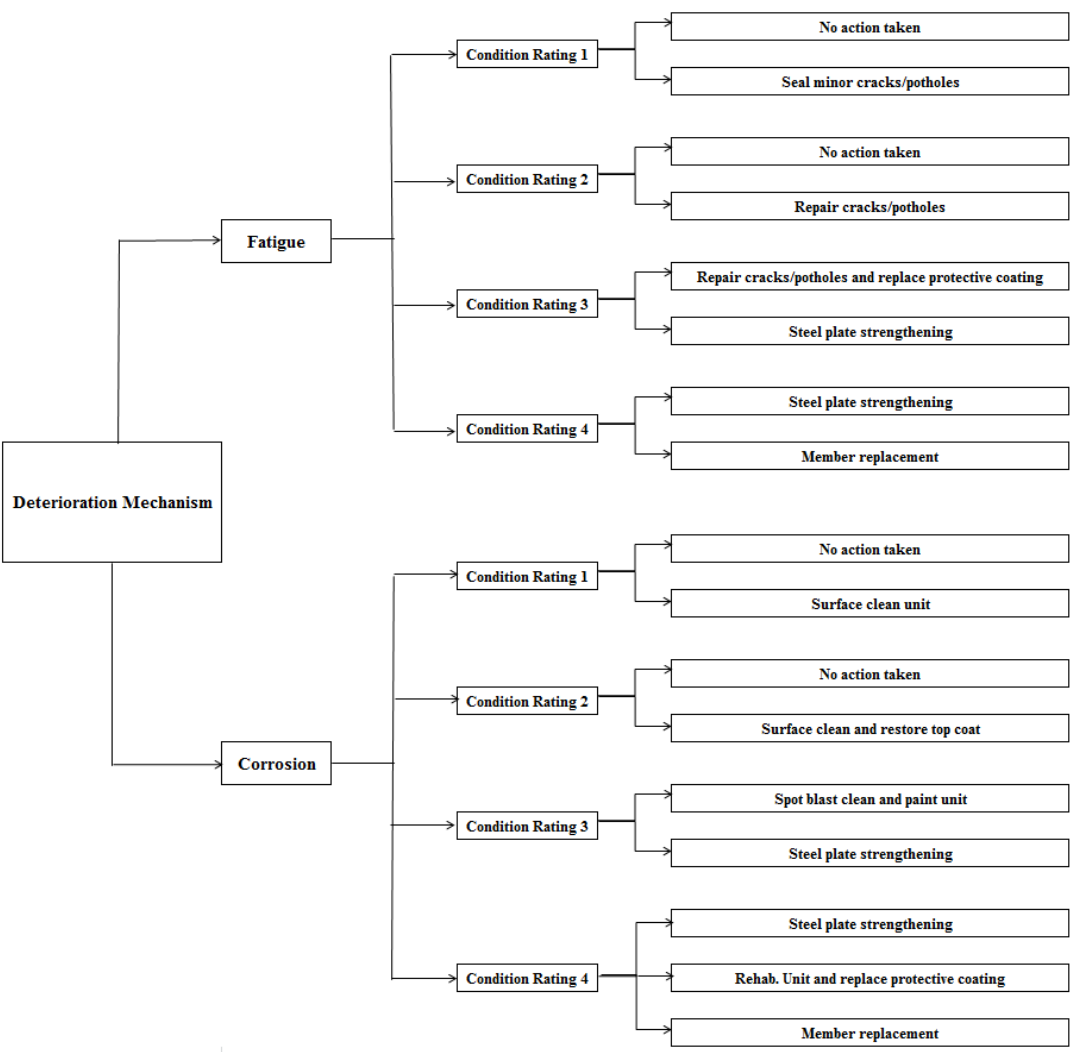
Figure 2. Available Concepts for Each Given Deterioration Scenario.